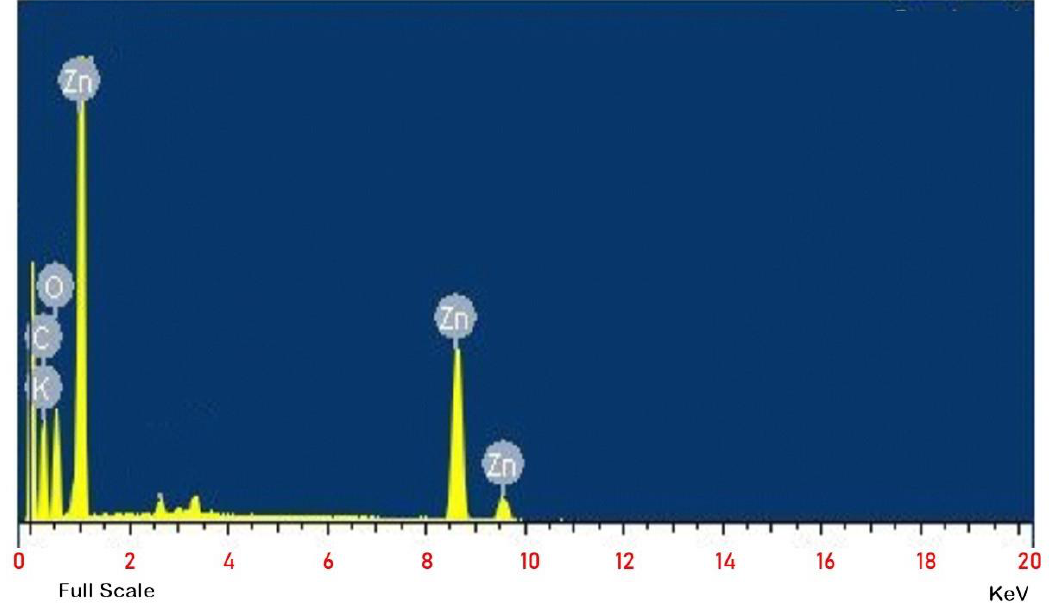
Figure 6. EDAX pattern for the green synthesized ZnO-NPs (Zn — zinc, O — oxygen, and C — carbon).